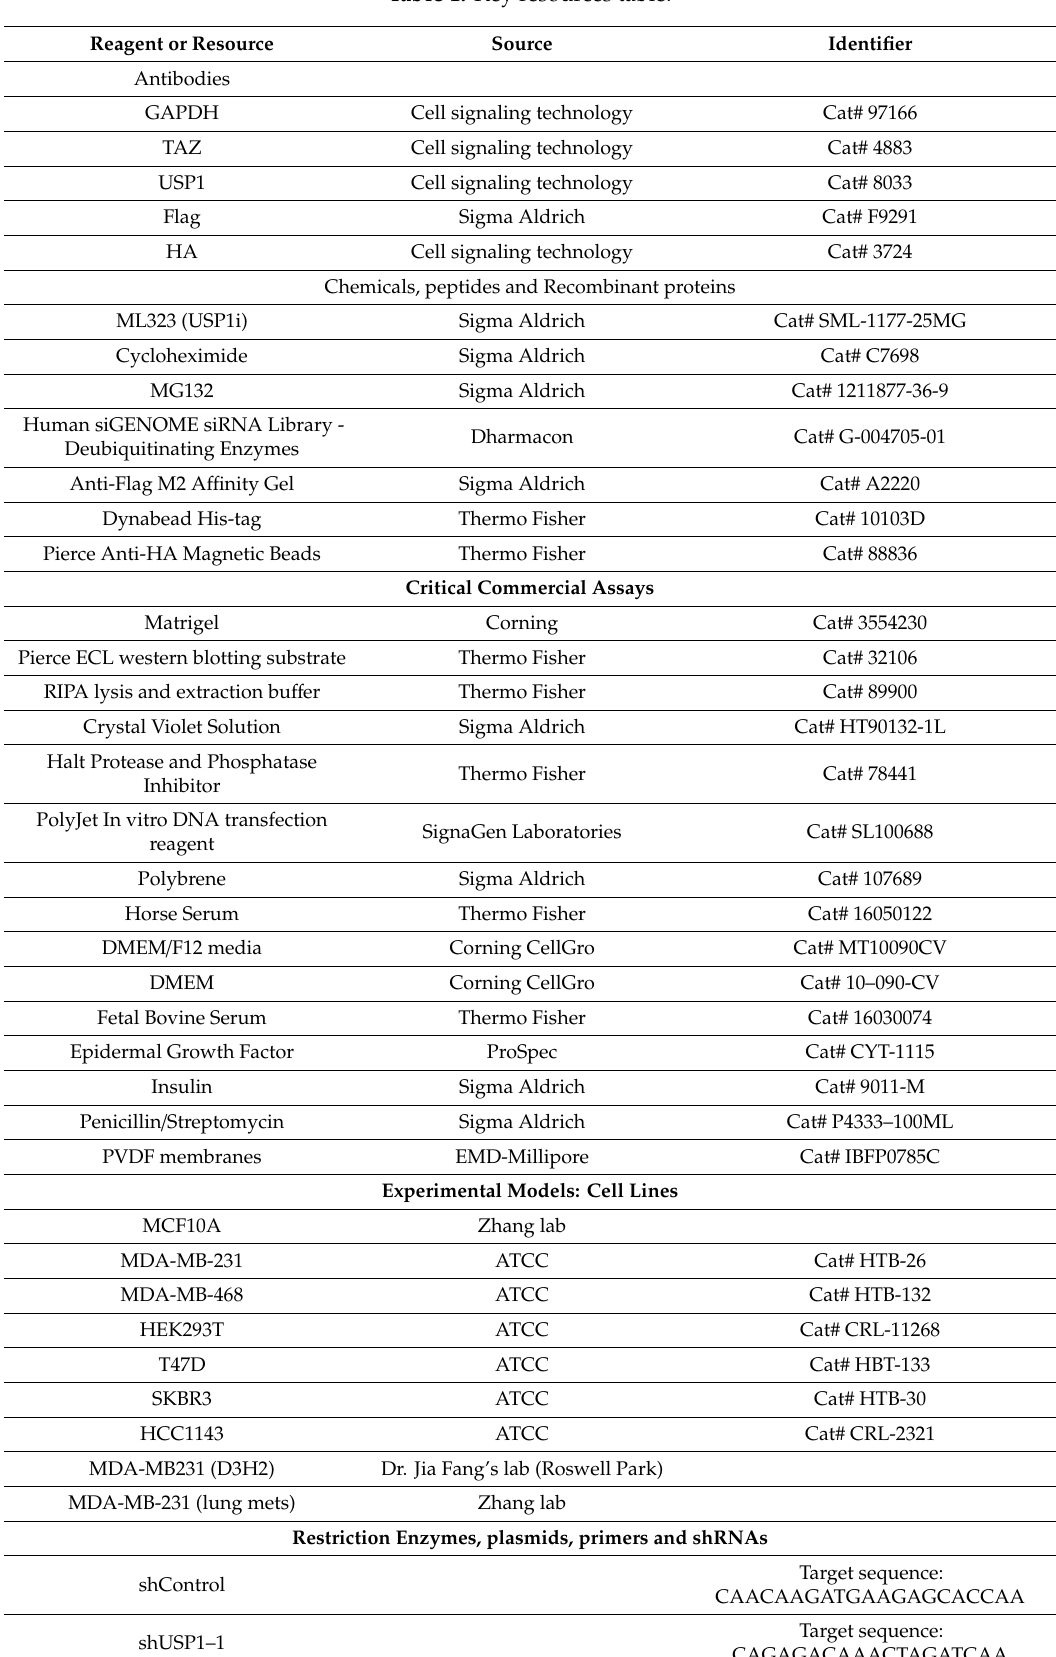
Table 1. Key resources